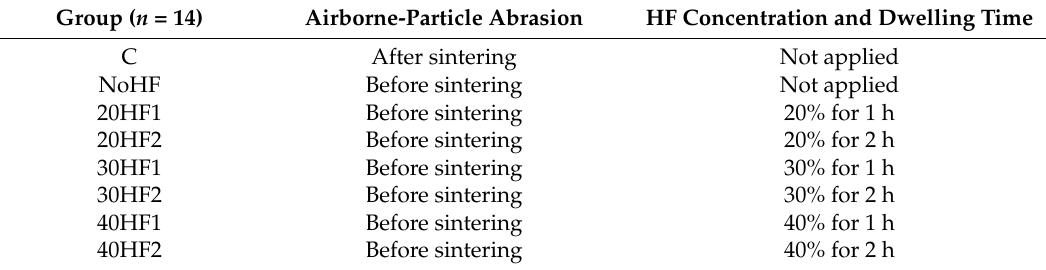
Table 1. Experimental groups and various surface